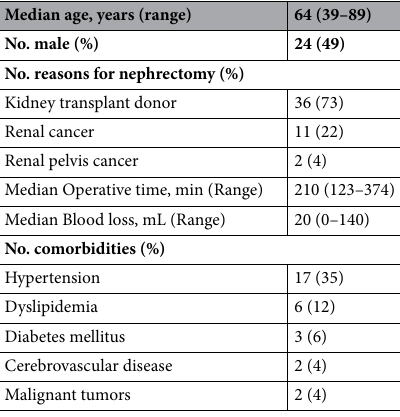
Table 1. Characteristics of the subjects (n =